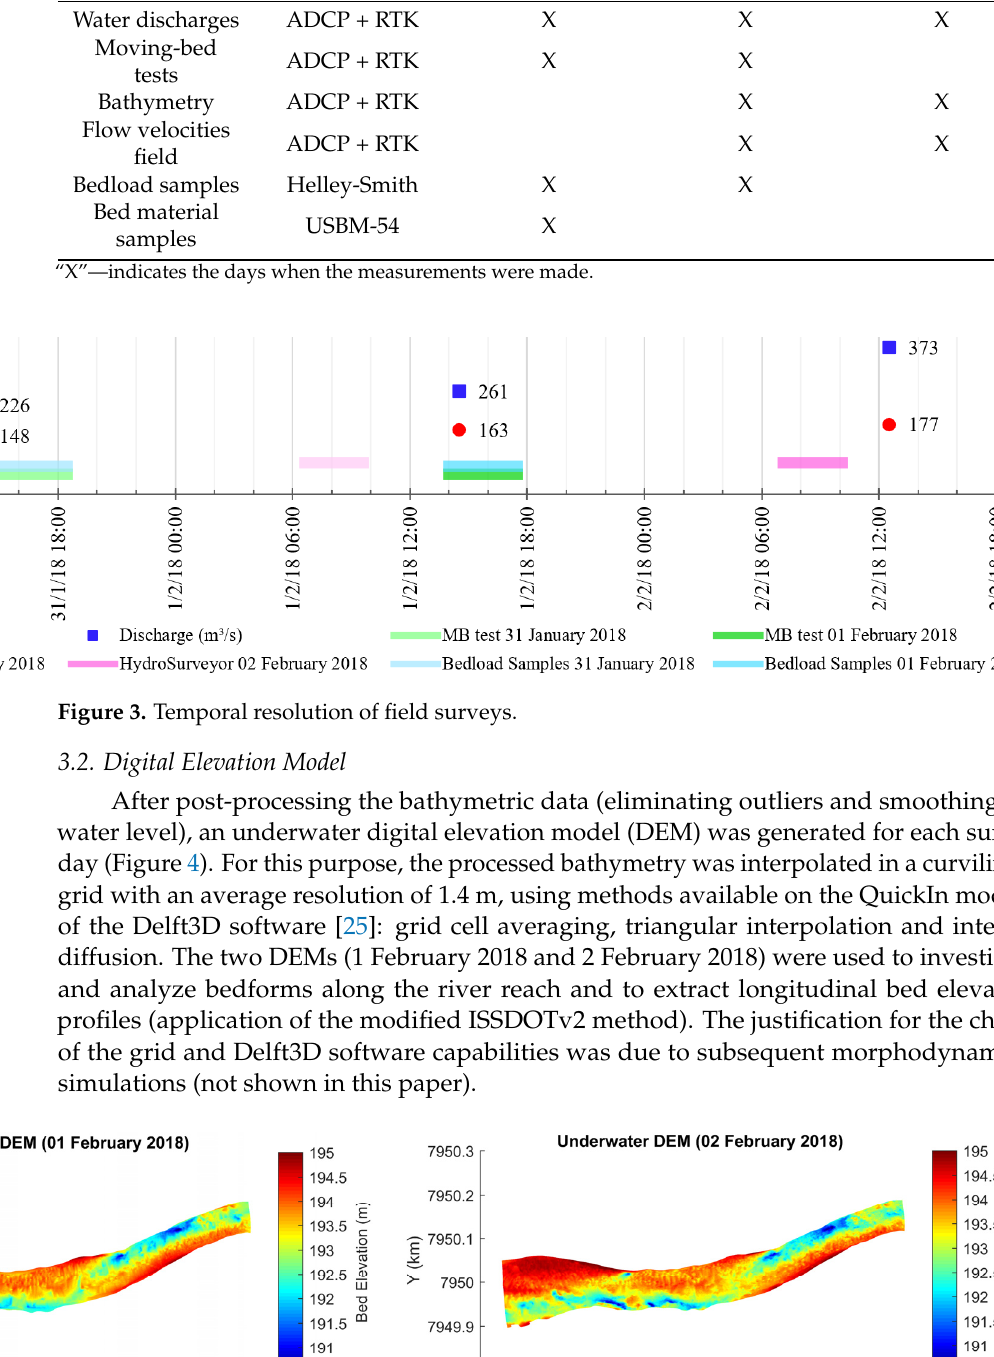
Table 1. Surveys carried out during the field campaign.